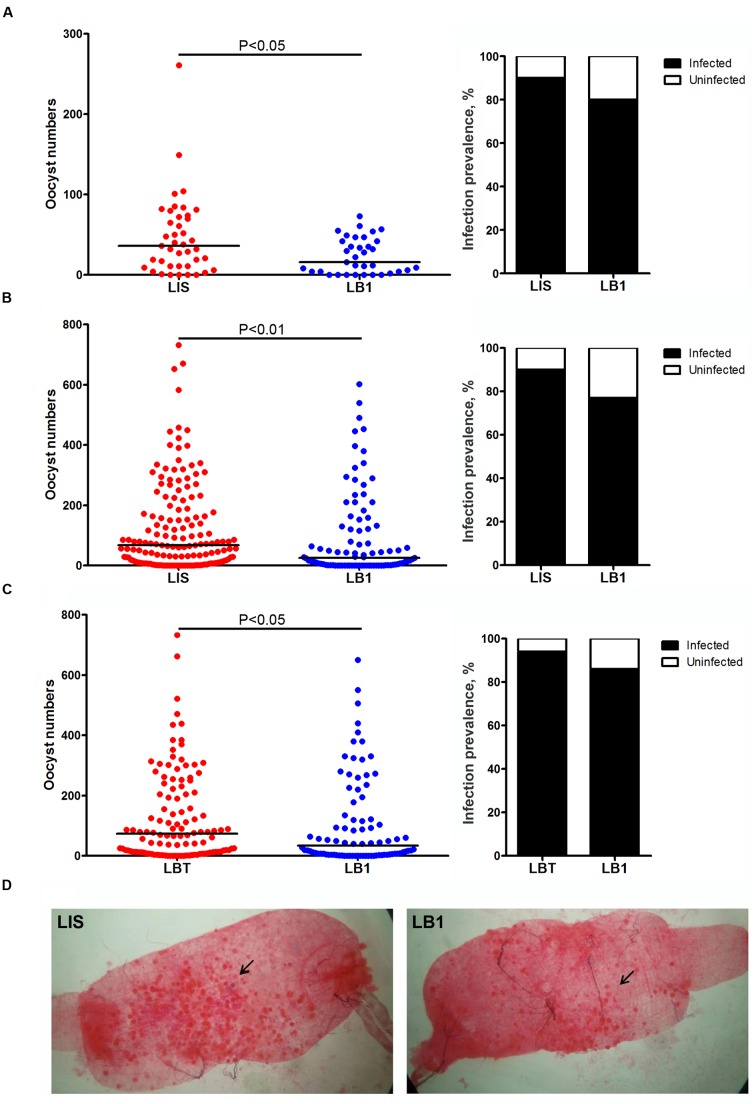
Wolbachia wAlbB-mediated reduction in Plasmodium berghei oocyst load in LB1 midguts. P. berghei oocyst loads in midguts of Anophelus stephensi LB1 strain and its infection prevalence (the percentage of mosquitoes that were infected at any level) are compared to those of LIS (A,B) and LBT strains (C). Points represent the number of parasites from an individual mosquito and horizontal lines indicate the median number of parasites per tissue. P-value is indicated based on Mann–Whitney test. (D) One representative midgut from LIS and LB1 strain is shown, with an arrow indicating the oocyst.